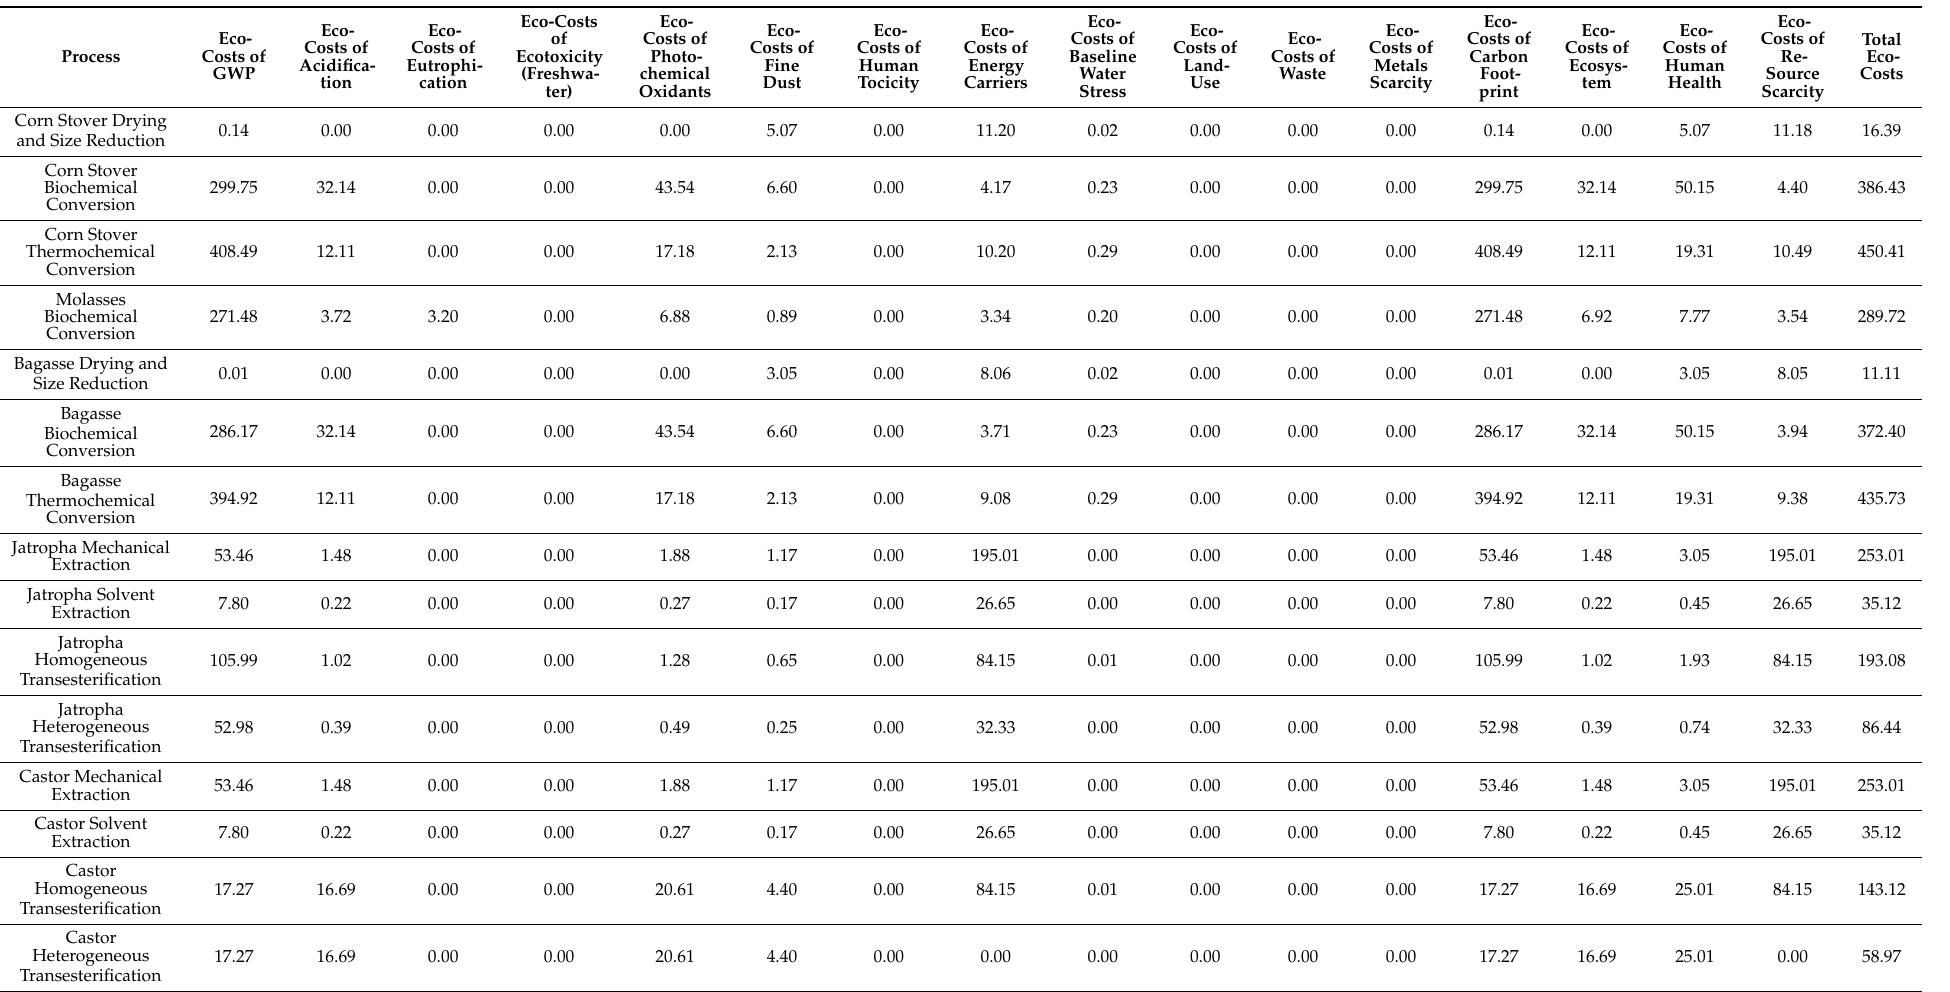
Table A1. Ecocosts associated with processing of raw and preprocessed biomass through the respective preprocessing and biorefinery technologies